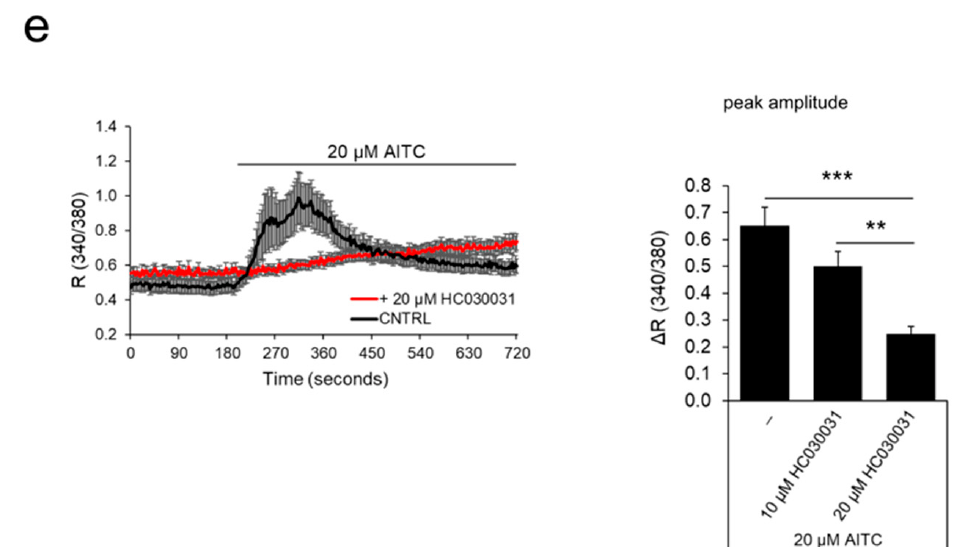
Figure 5. TRPA1 increases EC migration. ( a ) The ‘prostate-associated’ channels were overexpressed in HMECs to test their effect on cell migration. Expression of TRPA1 increased the migration of HMEC relative to control cells in basal medium, as observed by wound healing experiments. Lines show the mean value ± SEM of one out of three independent experiments (24 h after transfection). Statistical